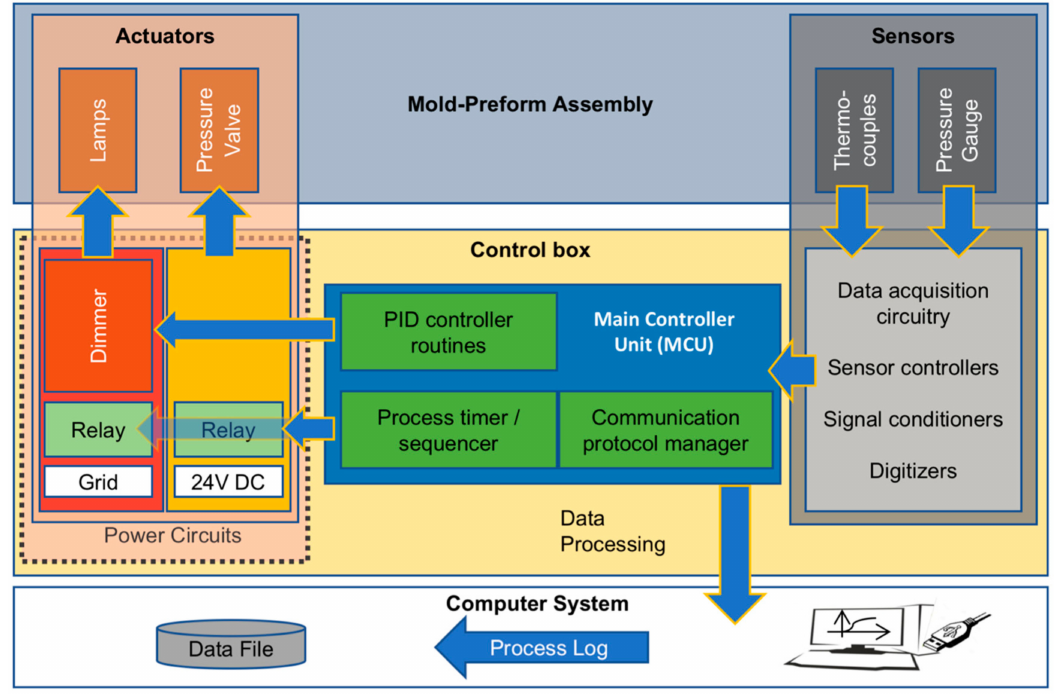
Figure 2. Block diagram describing the interface between the sensors, actuators, control unit and the data acquisition